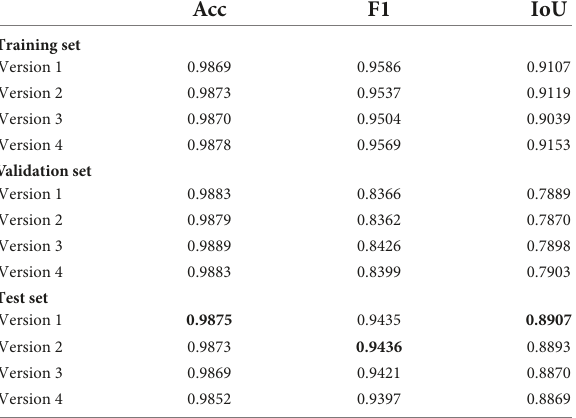
TABLE 2 Statistics for the evaluation indicators of the three